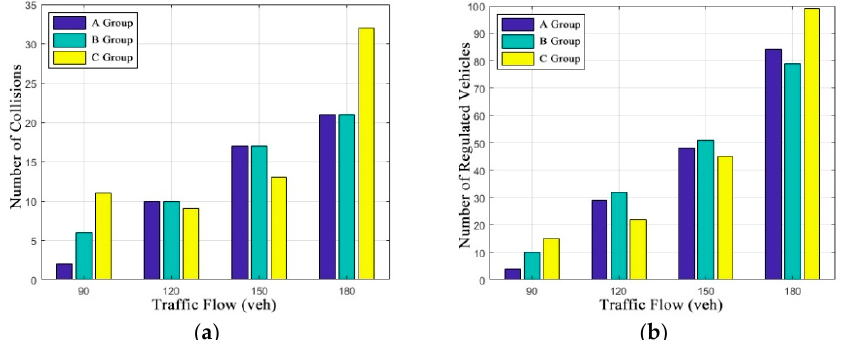
Figure 15. Results of conflict detection and resolution for different test scenarios. ( a ) The number of potential collisions; ( b ) the number of regulated vehicles.